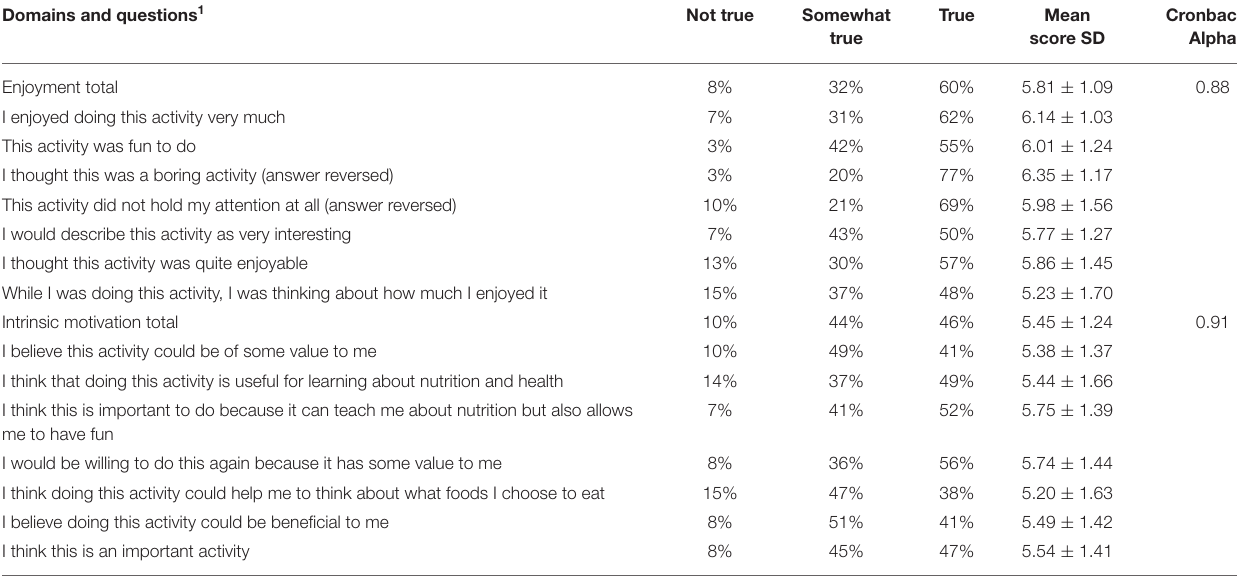
TABLE 3 | Assessment of enjoyment and intrinsic motivation questionnaire items of all educational escape game condition participants ( n = 72). Domains and questions